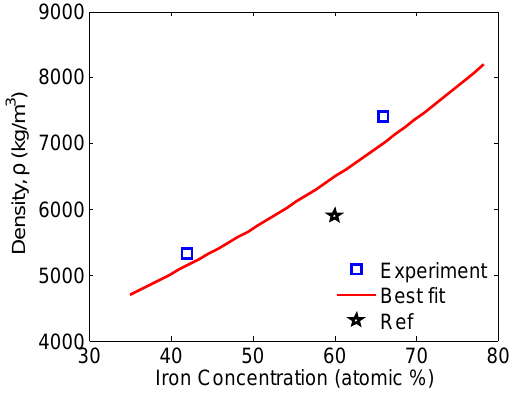
Figure 7. The variation of the density of the binary FeAl alloy as a function of the iron content. The data point shown by the pentagram is from reference